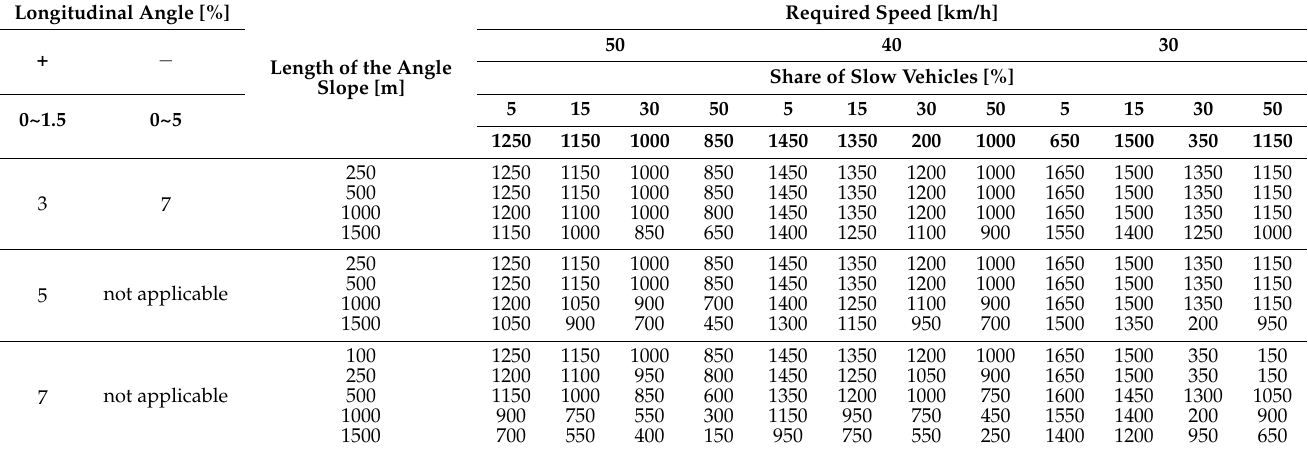
Table 1. Basic values of permissible traffic flow intensities I z on double-lane urban road [vehicle/h] [65]. Longitudinal Angle [%]